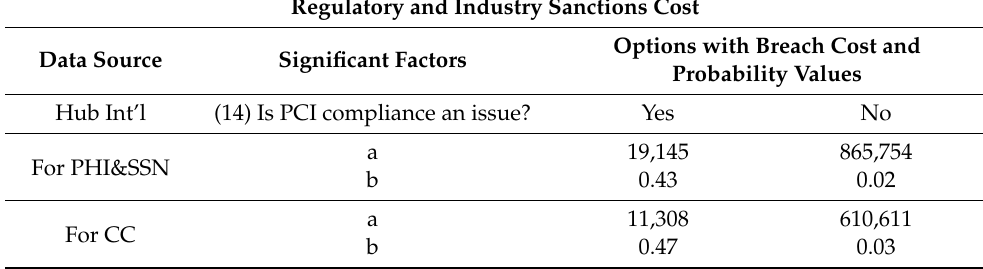
Table 7. The parameters a and b for the factors associated with the cost related to regulatory and industry sanctions.